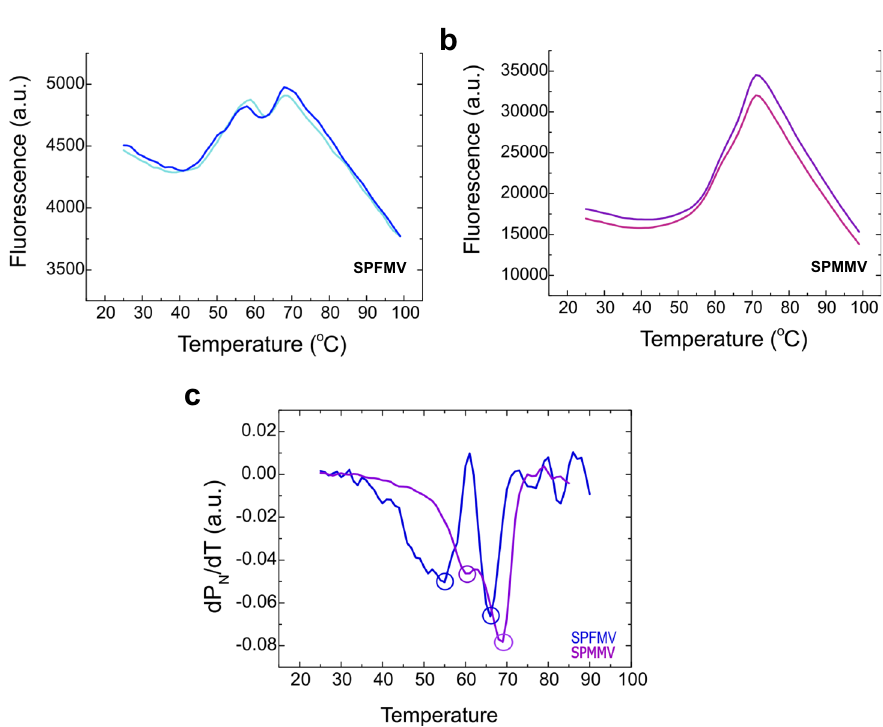
Fig. 3 Thermal stability assay of puri fi ed VLPs of SPFMV and SPMMV. a Differential scanning fl uorimetry analysis revealing 2 shifting temperatures for SPFMV-VLPs. b Differential scanning fl uorimetry analysis revealing 2 shifting temperatures for SPMMV-VLPs. c First derivative graphical representation of the melting temperatures for the two types of VLPs, after data normalization. For each type of VLPs, the fi rst shifting temperature (Tm1) accounts for the particle ’ s oligomeric dissociation, while the second (Tm2) represents most probably the CPs